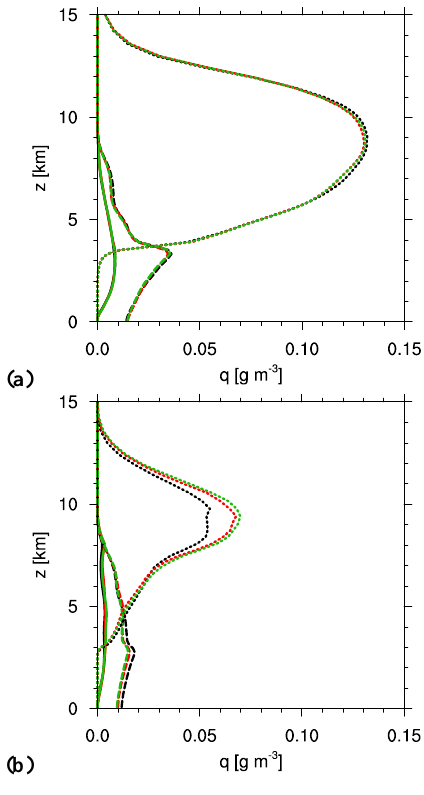
Fig. 16. Domain-averaged cloud (solid), rain (dashed), and ice (dot- ted) water contents for the bulk (left) and bin (right) simulations af- ter 2h of simulation time. The aerosol sensitivity is shown for the “Clean” (black), “Semi-Polluted” (red), and “IN-Polluted” (green)